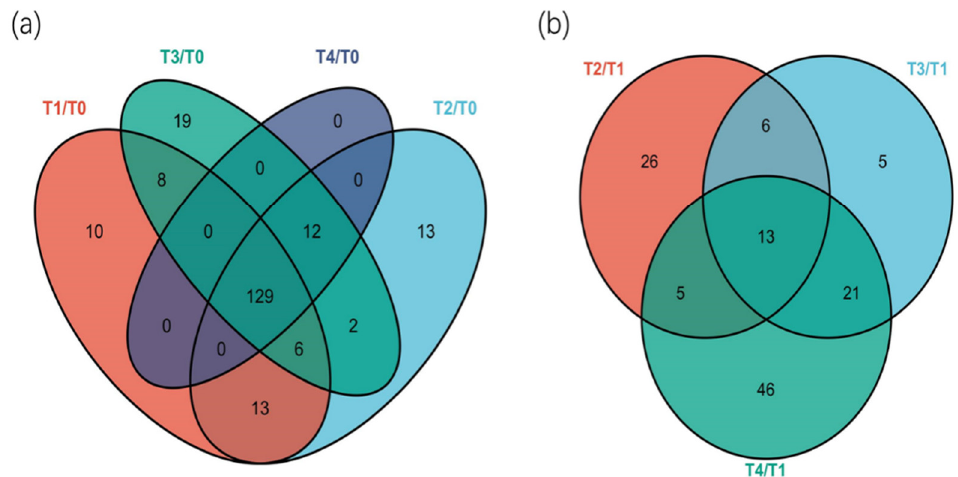
Figure 5. Venn plot of differentially expressed metabolites in young tea shoots under different fertilization treatments. Each circle represents a comparison group. The number of overlapping parts of each circle represents the number of common differential metabolites between the comparison groups, and the number of non-overlapping parts represents the number of specific differential metabolites between the comparison groups.